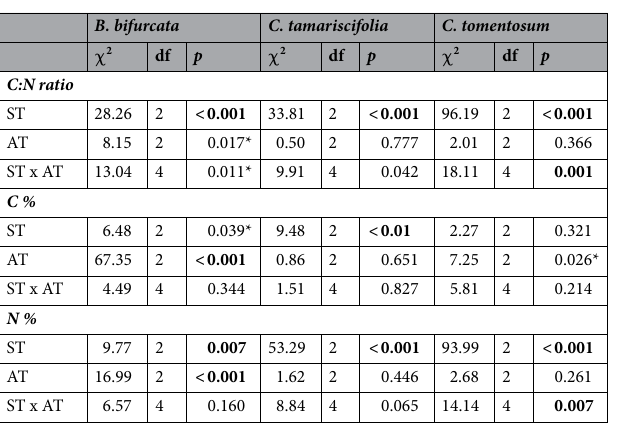
Table 2. The summarised results of GLMs testing the effects of seawater (ST) and air (AT) temperature on the C:N ratio, C% and N% of the fronds after the low tides and the recovery in the laboratory experiment. Significant effects ( p < 0.01) are shown in bold. * indicates marginal